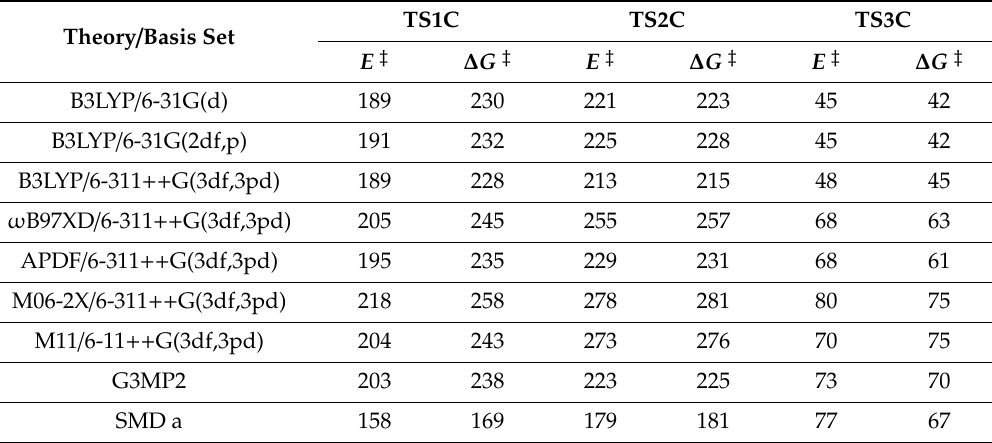
Table 2. Barrier Heights and Gibbs energies of activation (in kJ mol − 1 ) at 298.15 K for Pathway C.